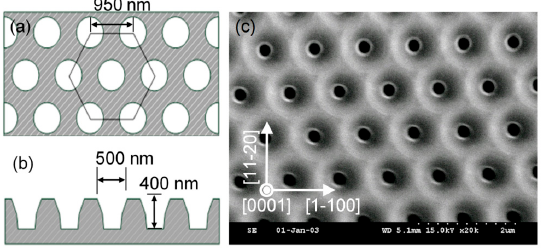
Figure 2. Schematic illustrations of the ( a ) top- and ( b ) side-view dimensions of the nanoscale- patterned sapphire substrate (NPSS) design used in this study. ( c ) SEM surface morphology of the as-etched NPSS.